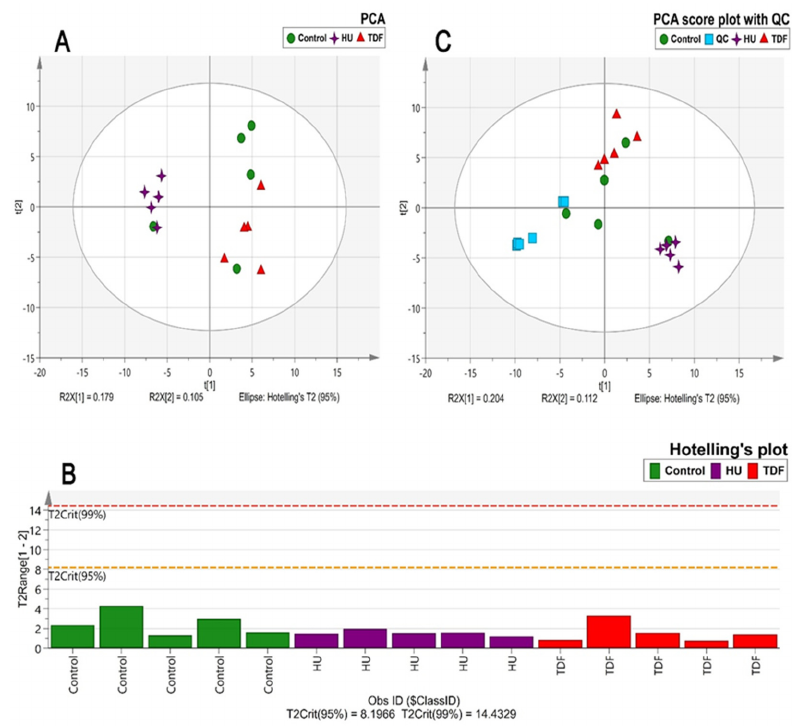
Figure 2. Multivariate statistical models ( A ) PCA score plot showing studied groups, ( B ) Hotelling’s T2 plot with 95% and 99% confidence limit for the outlier assessment in all groups, and ( C ) PCA score plot with QC samples.